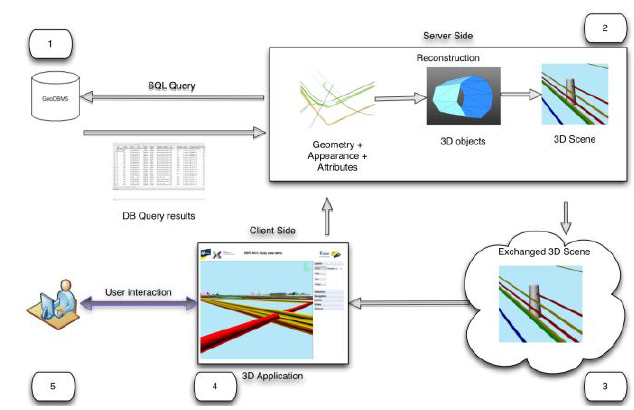
Figure 1: 3D reconstruction flow for pipe lines and